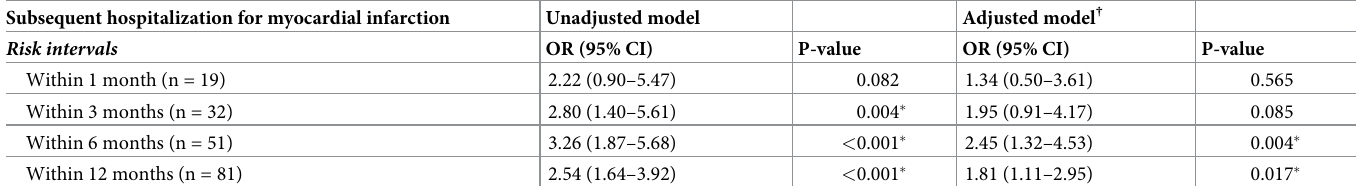
OR, odds ratio; CI, confidence interval. † With adjustment for age, sex, medical history of hypertension, diabetes, dyslipidaemia, and atrial fibrillation/atrial flutter, period (before or after April 2009) and